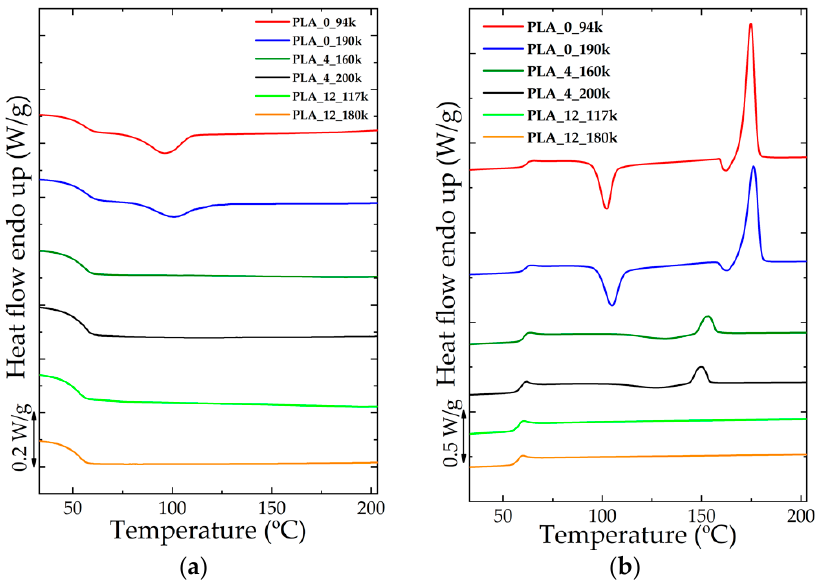
Figure 1. Cooling ramp ( a ) and heating ramp ( b ) obtained by DSC calorimetric analysis for the six materials.